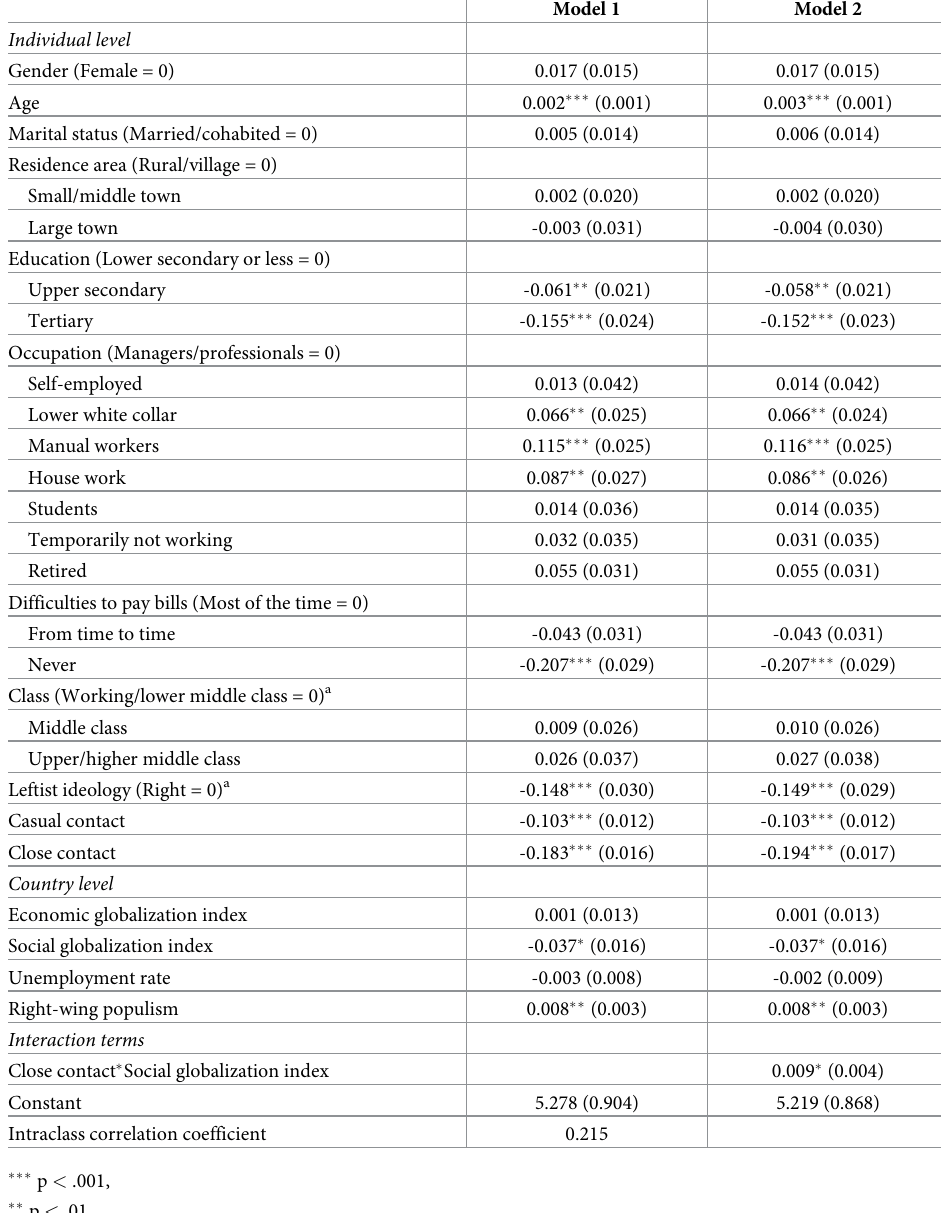
Table 4. Multilevel analysis of the social distance (N =